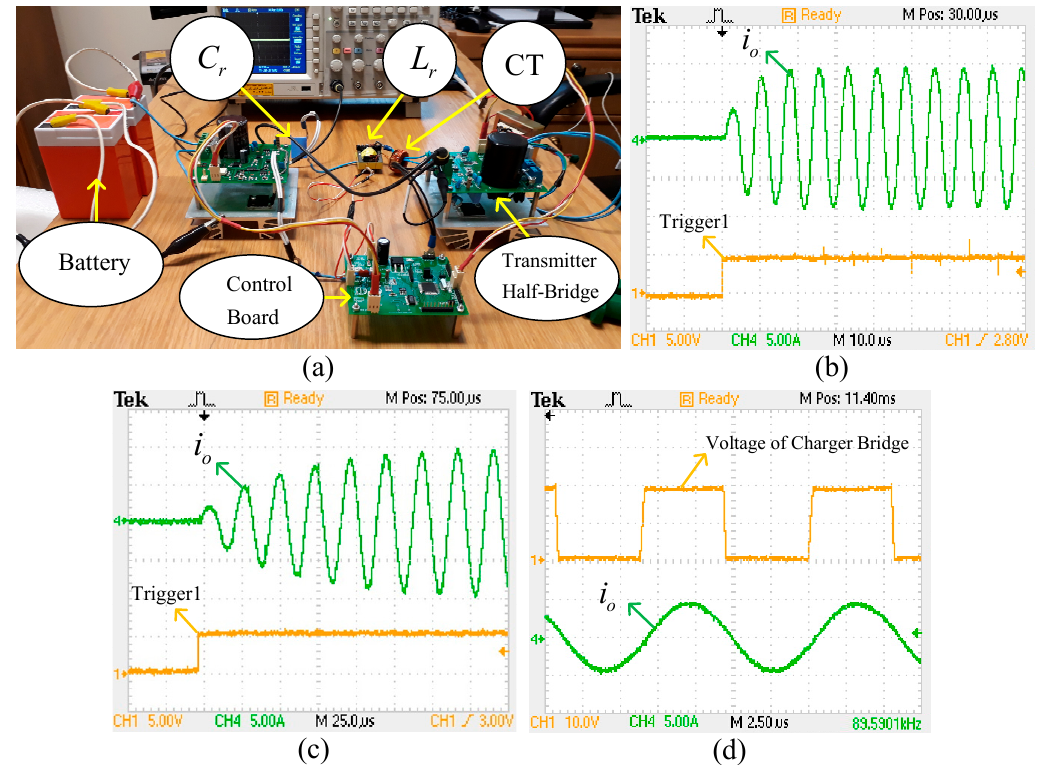
Figure 14. ( a ) Experimental setup of the SRC based on the proposed tuning loop. ( b ) Trigger1 signal and output current of the charger inverter at start-up condition while C r ≈ 180 nF, τ 1 ≈ 2.2 µs and τ 2 ≈ 1 µs. ( c ) Trigger1 signal and output current of the charger inverter at start-up while C r ≈ 1200 nF, τ 1 ≈ 16 µs and τ 2 ≈ 1 µs. ( d ) Output voltage of the charger bridge and i o with C r ≈ 1200 nF , τ 1 = 3.6 µs and τ 2 = 1µs.